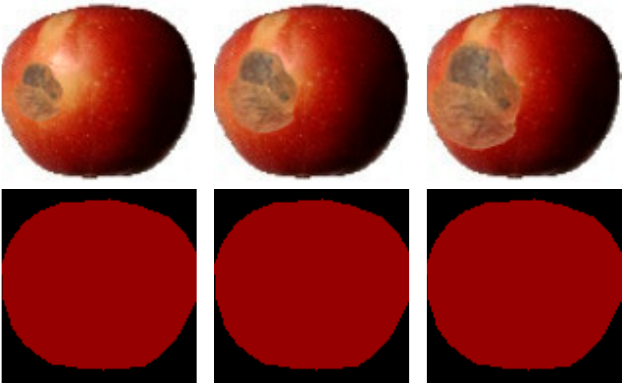
Figure 4. Apple images with different degrees of rot and their labels.